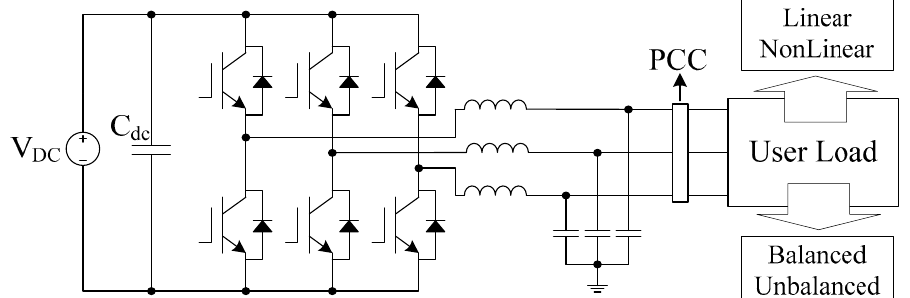
Figure 1. Schematics of the VSI within a three-phase stand-alone system.